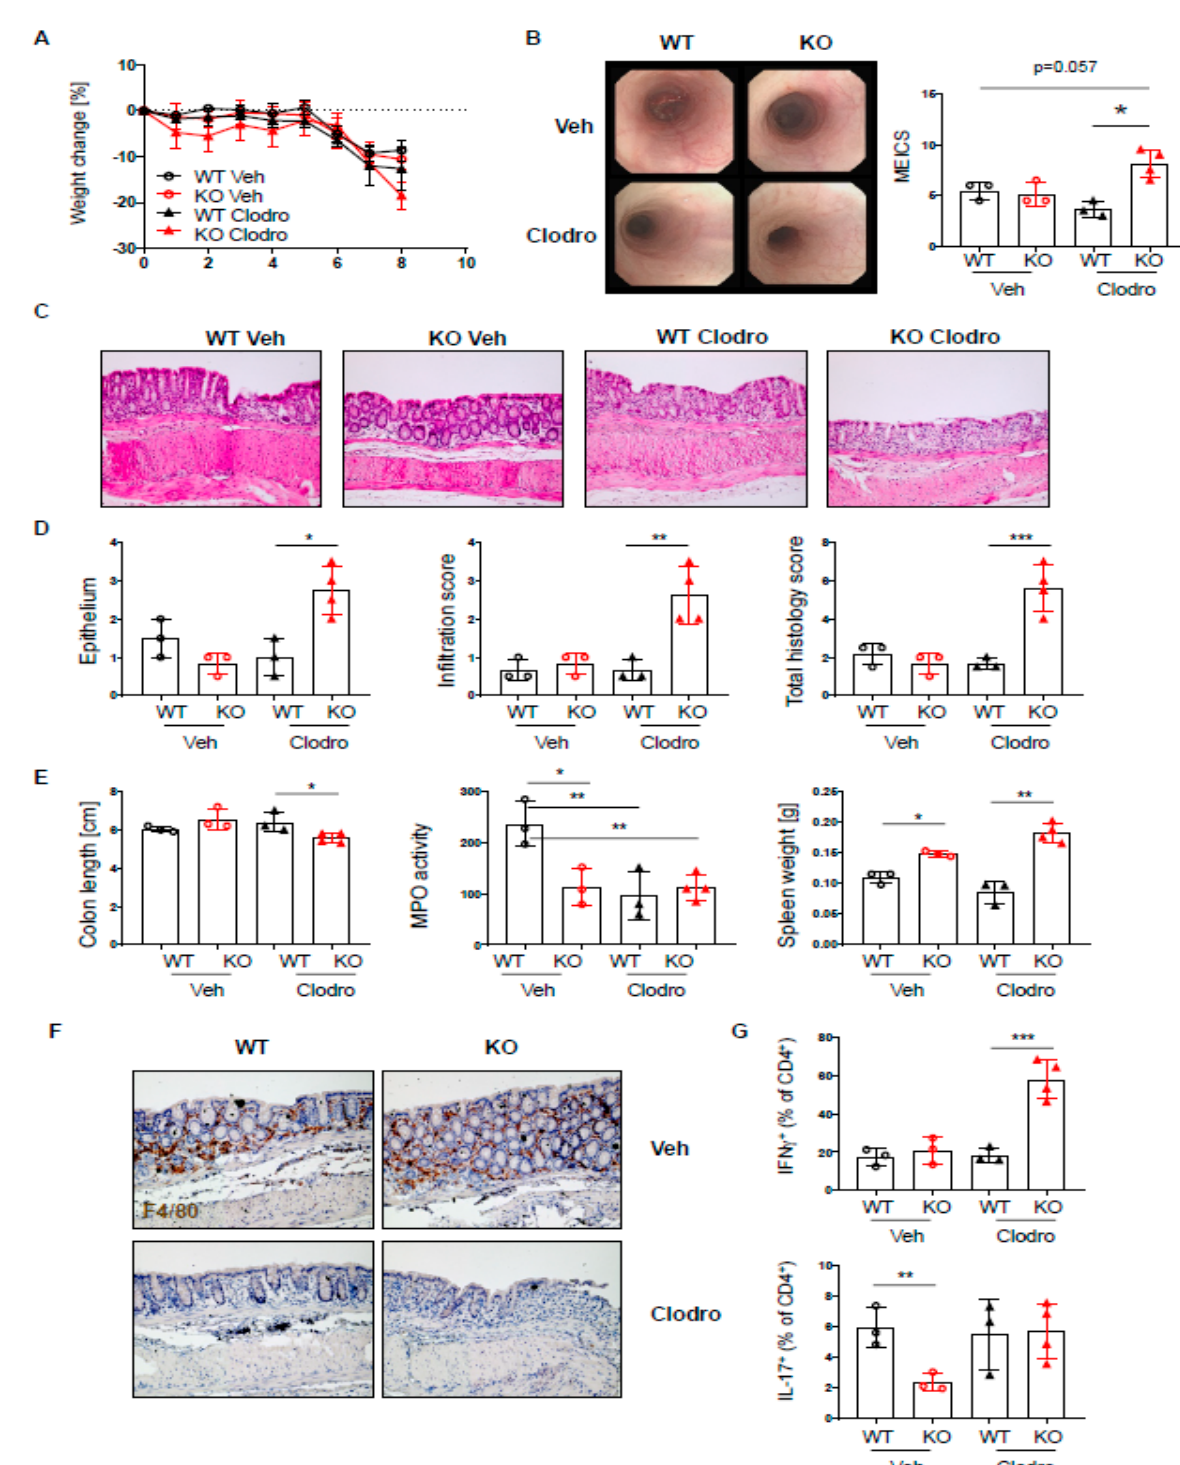
Figure 7. Macrophages protect PTPN2 fl/fl xCD11c Cre mice from elevated colitis. PTPN2 fl/fl (WT) and PTPN2 fl/fl xCD11c Cre (KO) mice received 2.5% DSS for 7 days and were treated with vehicle liposomes or clodronate liposomes on day-1, day 2, and day 4 to deplete macrophages: ( A ) weight development post injection; ( B ) representative pictures from colonoscopy and assessment of colitis severity according to the murine endoscopic index of colitis severity (MEICS); ( C , D ) representative pictures from H&E staining of the terminal colon and histological scoring; ( E ) colon length, MPO activity, and spleen weight; ( F ) IHC staining for F4/80 + macrophages in the colon; ( G ) frequencies of IFN γ + and IL17 + CD4 + T cells in the lamina propria. * p < 0.05, ** p < 0.01, *** p < 0.001; unpaired Mann–Whitney test. Data are representative for one out of two independent experiments with 3–4 mice per experimental group.